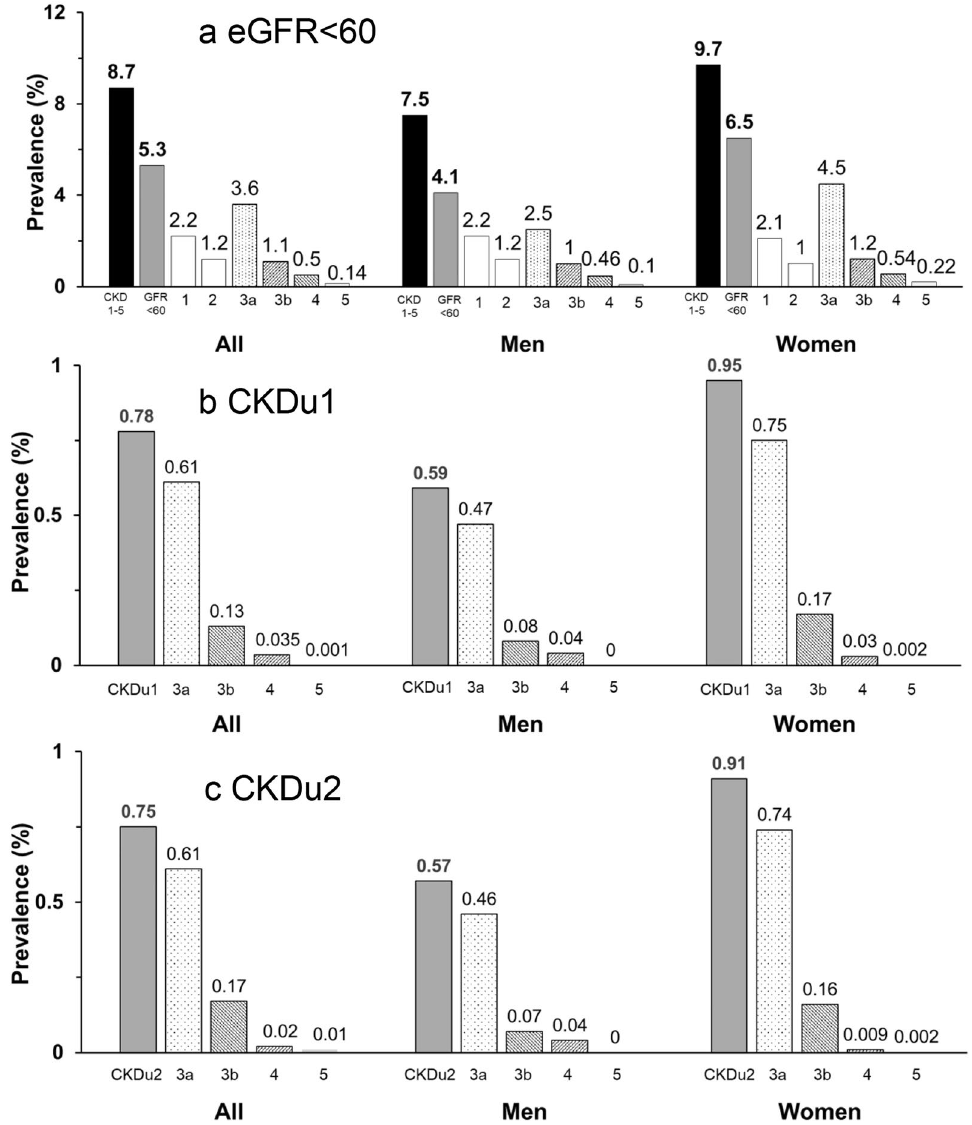
Figure 1. Adjusted Prevalence and Stage of ( a ) CKD1-5, eGFR < 60; ( b ) CKDu1; ( c ) CKDu2 in all adults. Prevalence probability weighted for the registered 2014 Thai population stratified by age, sex, area of residence (urban/rural), and geographic